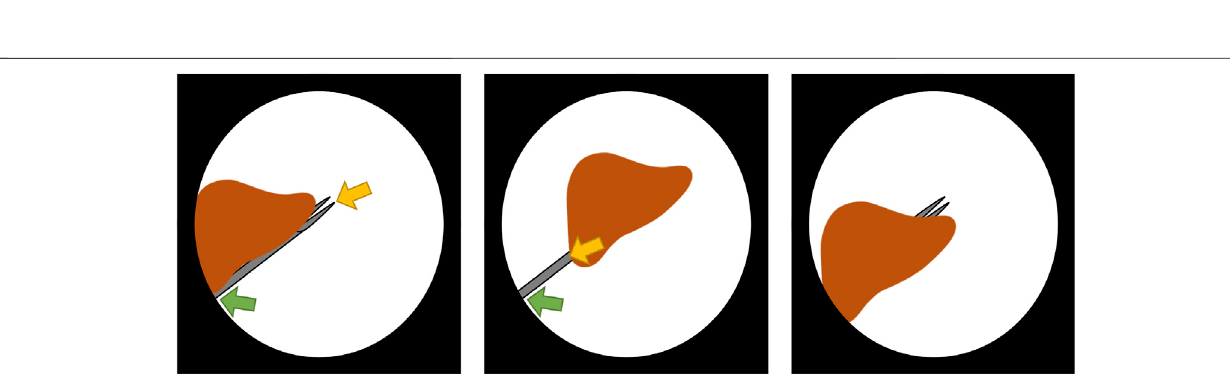
Frontiers in Robotics and AI |